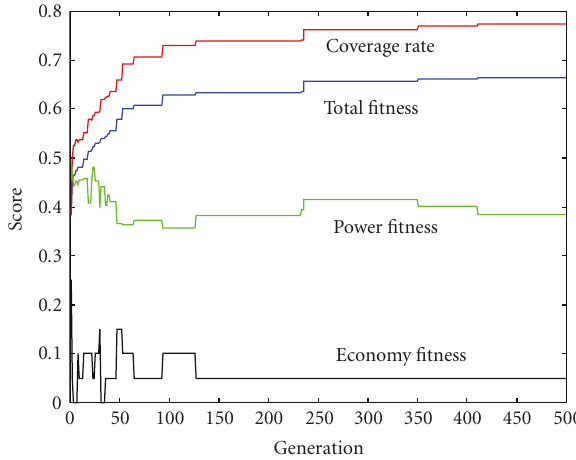
Figure 22: Fitness values, ( ω t , ω p , ω e ) = (0 . 8,0 . 1,0 .